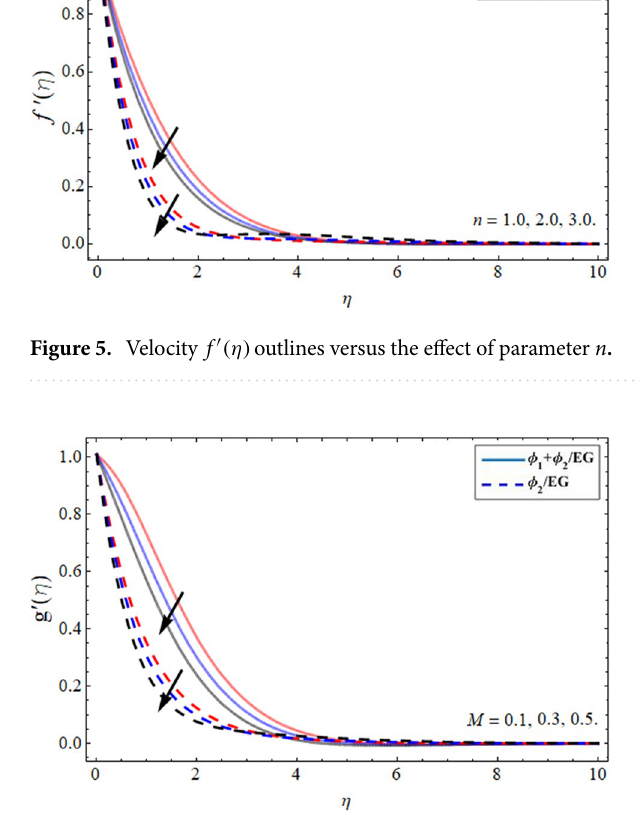
Figure 6. Velocity g ′ (η) outlines versus the effect of magnetic term M .